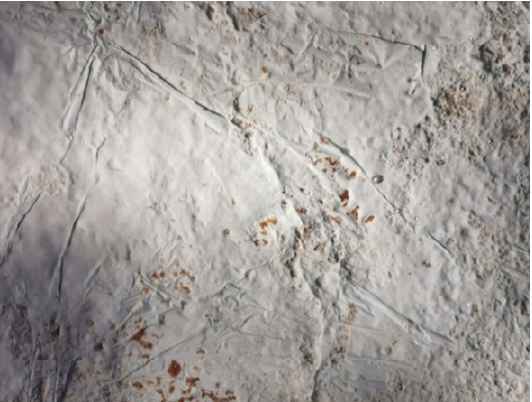
Figure 6. Mycelium-based material during growth (design and photo: A. Bonenberg).